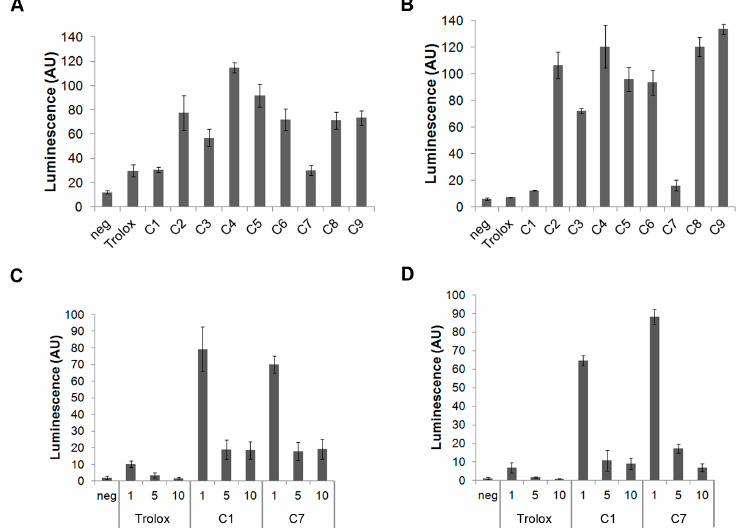
Figure 1. Luminescence detected when cells were: untreated (negative), treated with PMA (1 µM) alone, or with an antioxidant (10 µM) in RAW264.7 cells ( A ); or THP-1 cells ( B ). The luminescence produced by RAW264.7 cells ( C ) or THP-1 cells ( D ) when exposed to Trolox, C1, or C7 at 1, 5, or 10 µM. In both figures the values are presented normalized to the positive control, and expressed as %. Values expressed as mean ± standard deviation.